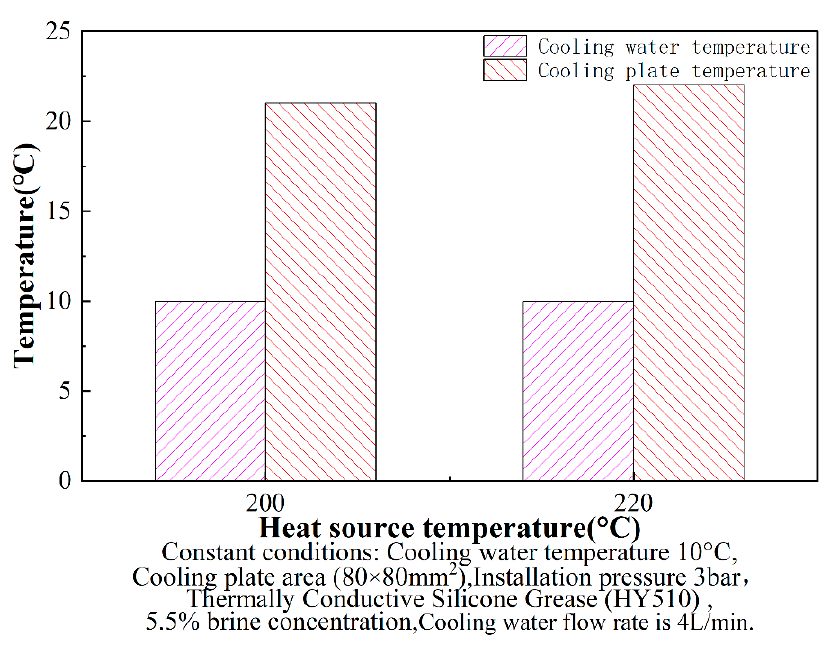
Figure 10. Effect of heat source temperature on cooling plate temperature.